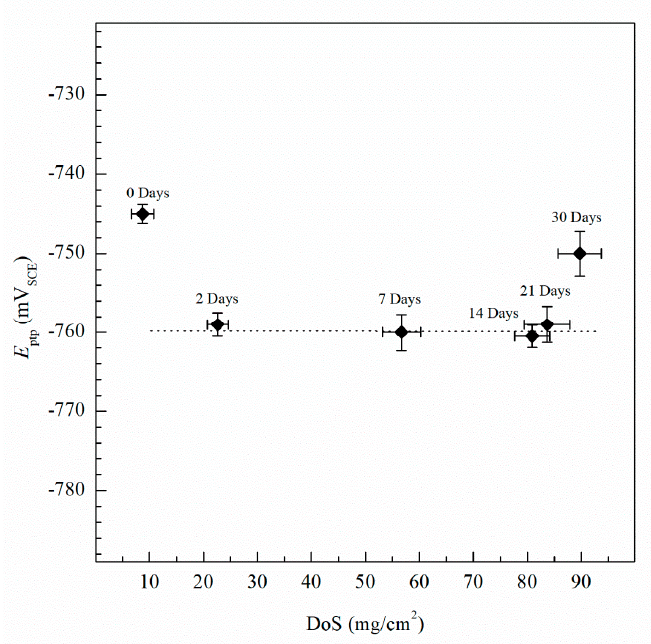
Figure 6. Average pitting transition potential ( E ptp ) measured by CPP for varying DoS measured by NAMLT. Error bars represent the standard deviation from the mean. Dotted line represents the average E ptp after sensitization, − 760 mV SCE . Error bars represent standard deviation from the mean.